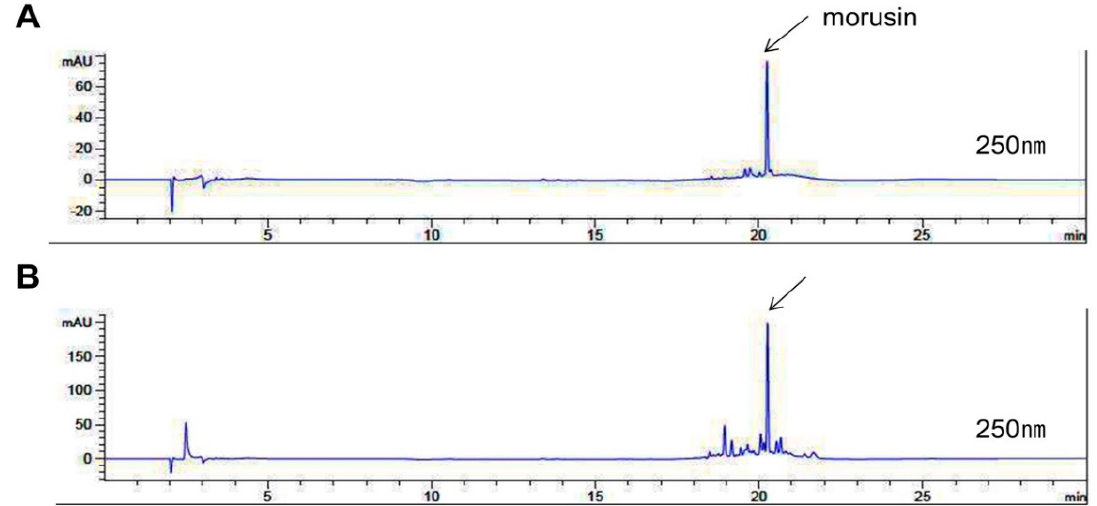
Figure 1. HPLC analysis of standard solution and methylene chloride extracts of Morus alba L. (MEMA). Small samples of morusin was separated in parallel with MEMA using HPLC system. Total HPLC-chromatograms of morusin ( A ) and MEMA ( B ) obtained at a UV wavelength of 250 nm. The indicated peak was identified as morusin according to retention time and UV-Vis spectra of standards. Table 1. Comparison of retention time between MEMA and standard morusin by HPLC analysis.